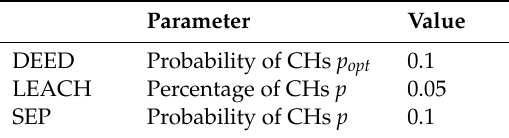
Table 3. Setting parameters of compared